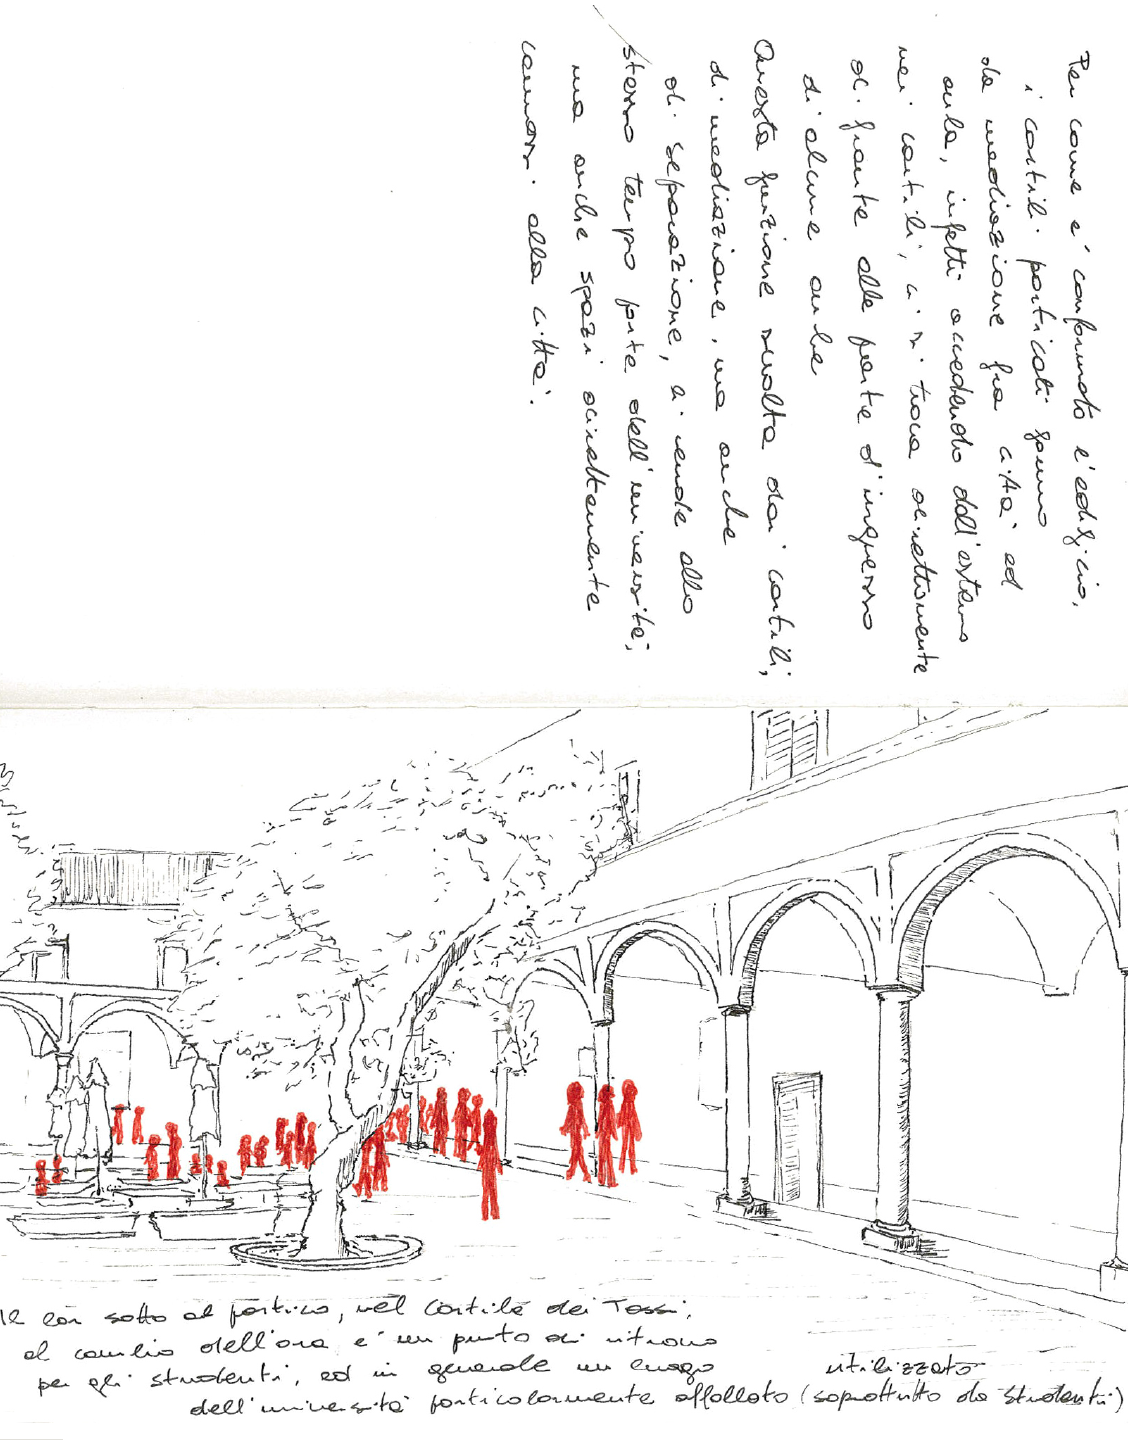
Sketches derived from non-interactive observation of the University courtyards FIG. (image by Francesco Cavalloro, Alberto Pettineo).